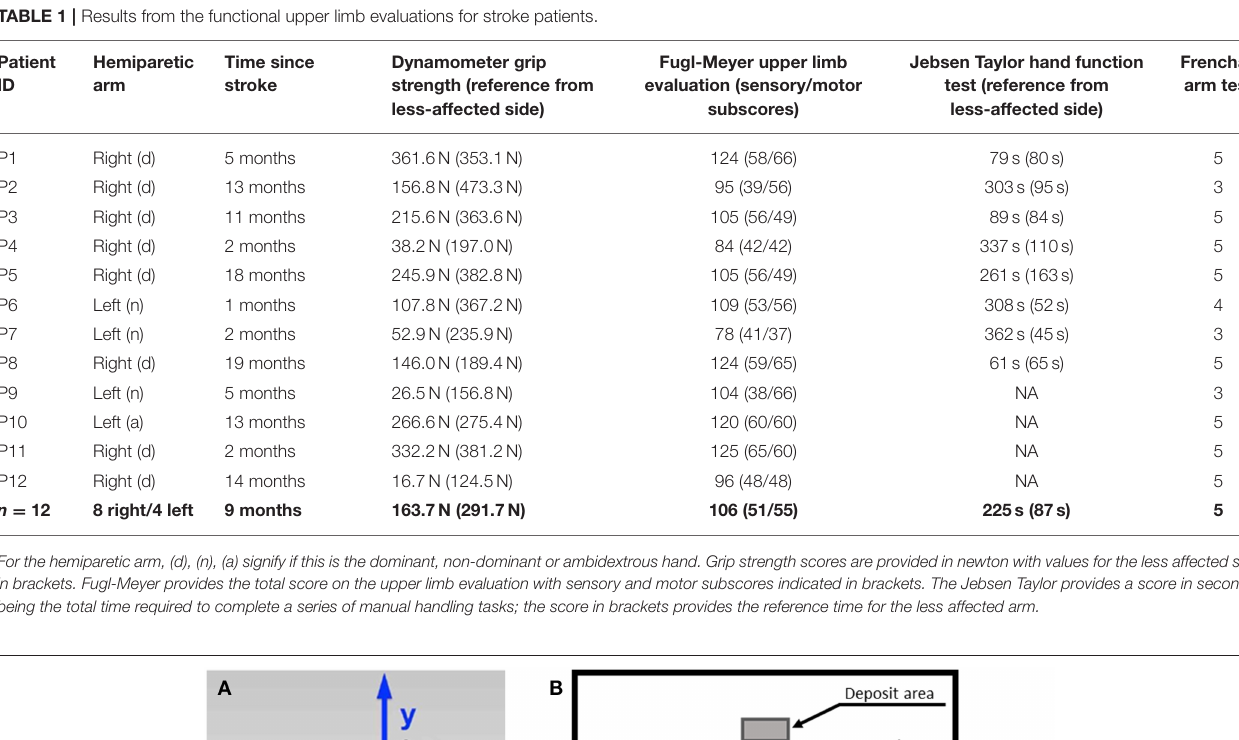
TABLE 1 | Results from the functional upper limb evaluations for stroke patients. Patient Hemiparetic Time since ID arm stroke